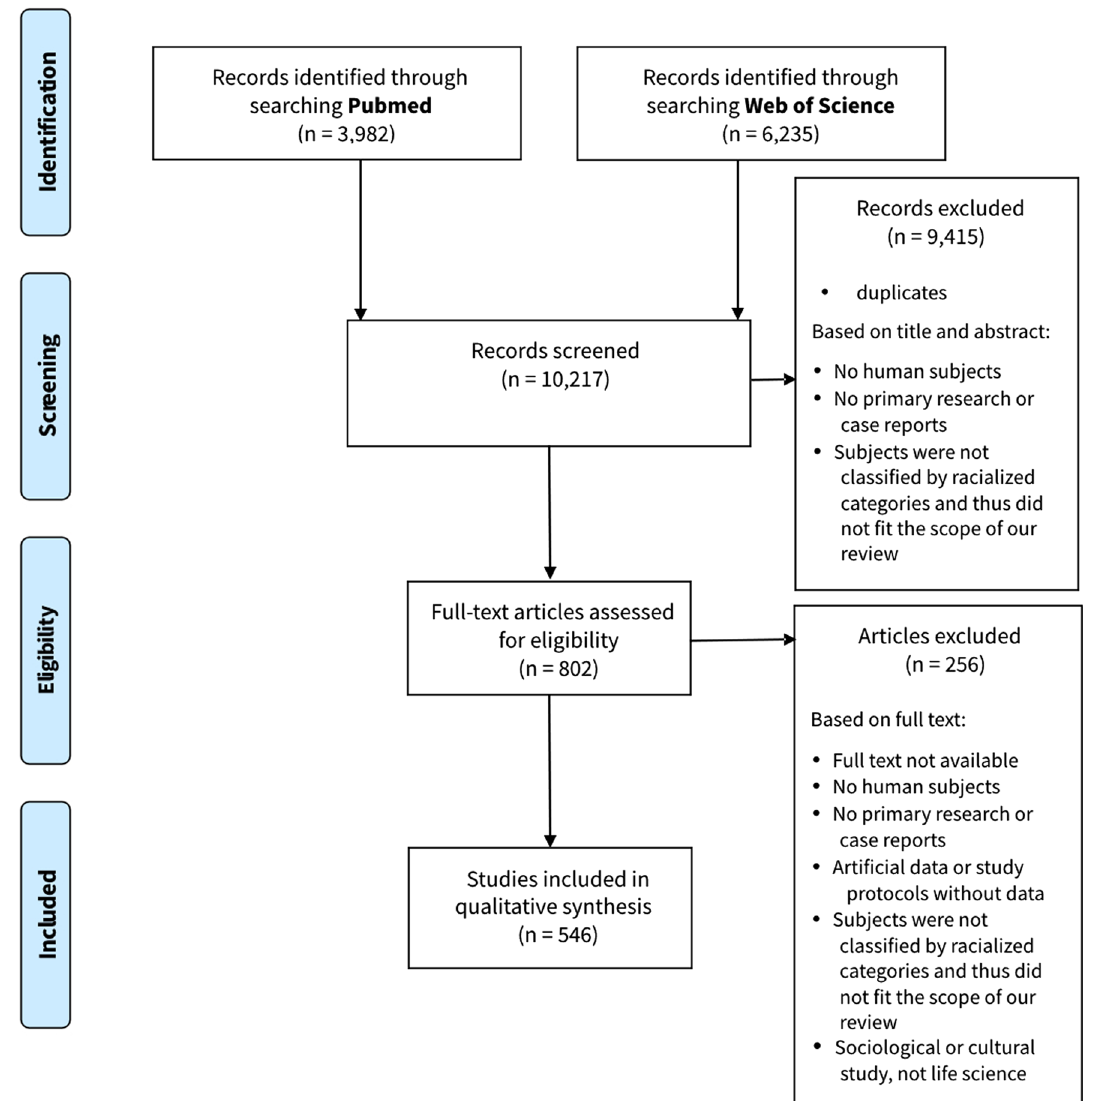
Fig. 1 Flow chart for the selection of studies for the systematic literature review. Adapted from Page et al.